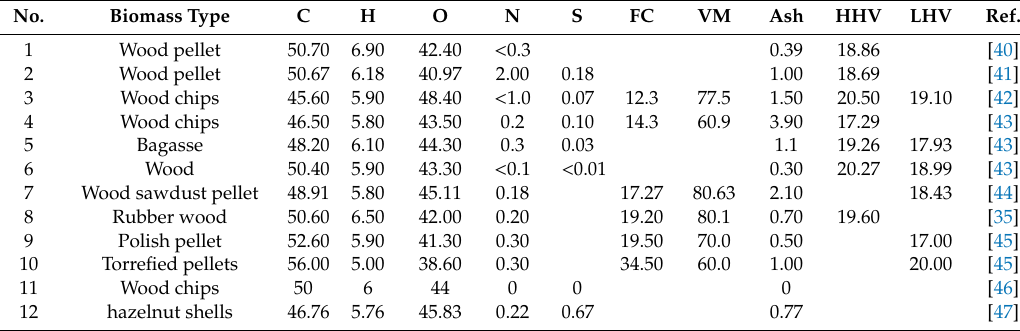
Table 4. Ultimate and proximate analysis of di ff erent biomass feedstocks. (% dry mass for composition and MJ / kg of dry mass for HHV and